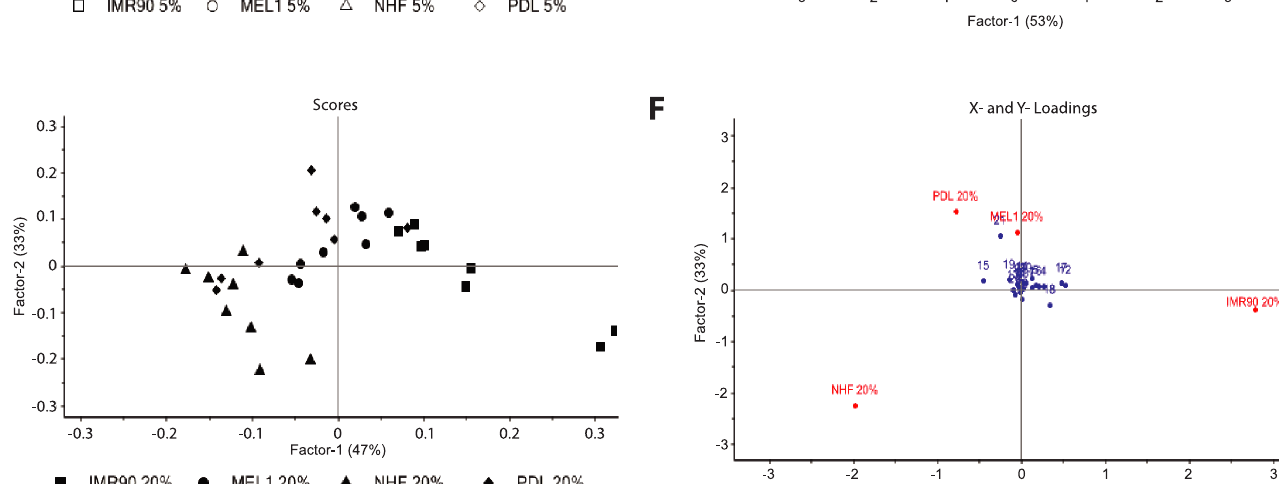
PLOS ONE | https://doi.org/10.1371/journal.pone.0193949 March 15,